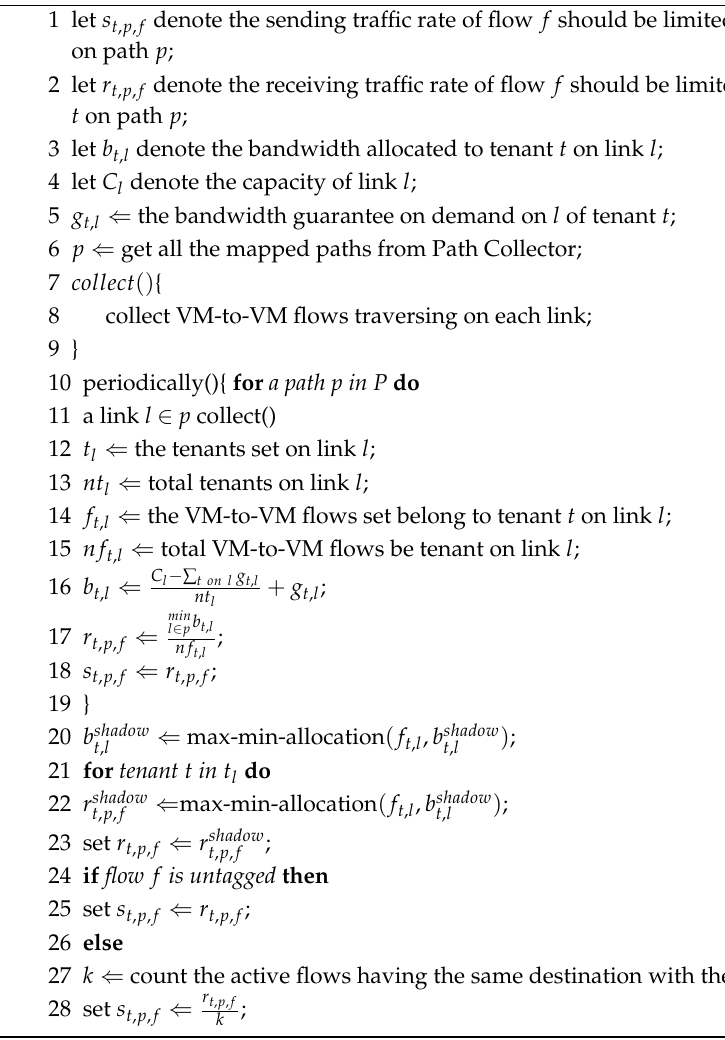
Algorithm 1: Hierarchical max–min